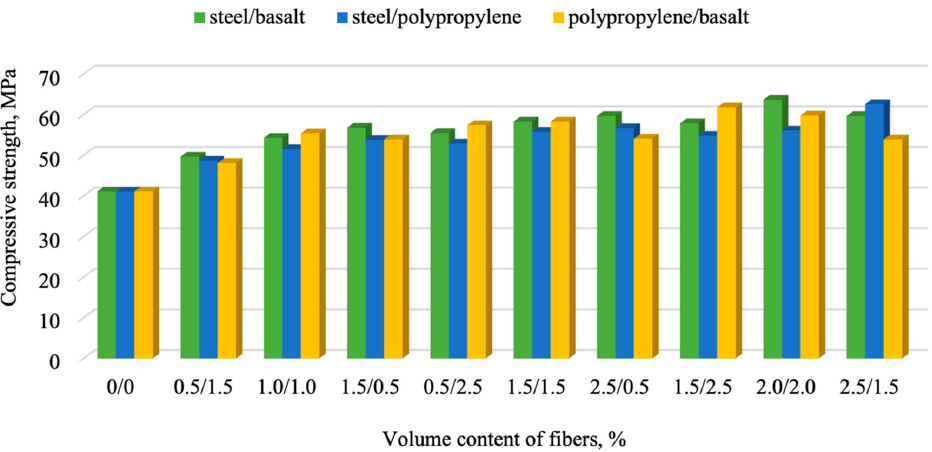
Figure 7. Dependence of the compressive strength of fiber-reinforced concrete on the type of fiber combination and volume content.